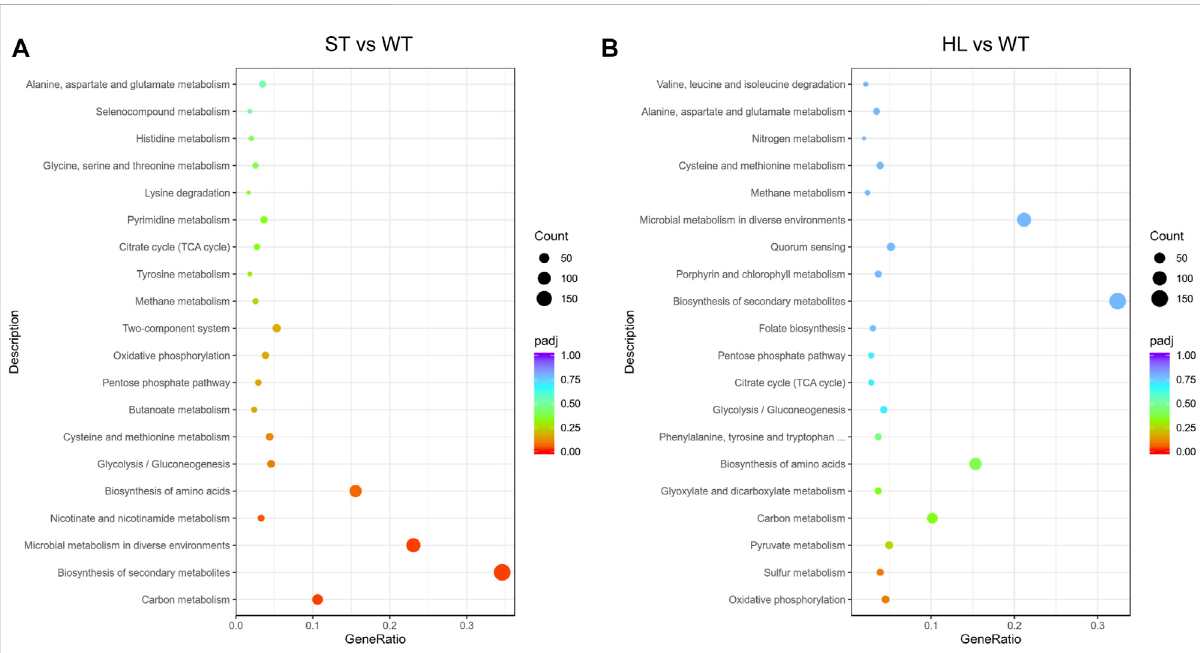
FIGURE 2 ScatterplotofenrichedKEGGpathwayanalysisinST (A) andHL (B) samplescomparedwiththeWTcontrol.The x -axisrepresentstherichfactor corresponding to each pathway, and the y -axis indicates theKEGG pathways. The dot denotes thenumber of DEGs, and thecolor re fl ects therange of a corrected p -value (padj). The top 20 most enriched KEGG pathways are